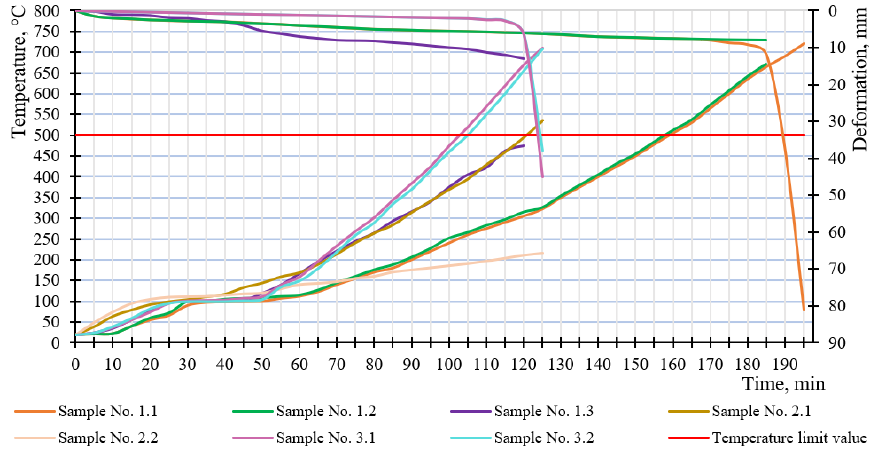
Figure 4. Temperature and deformation curves of samples during fire tests.